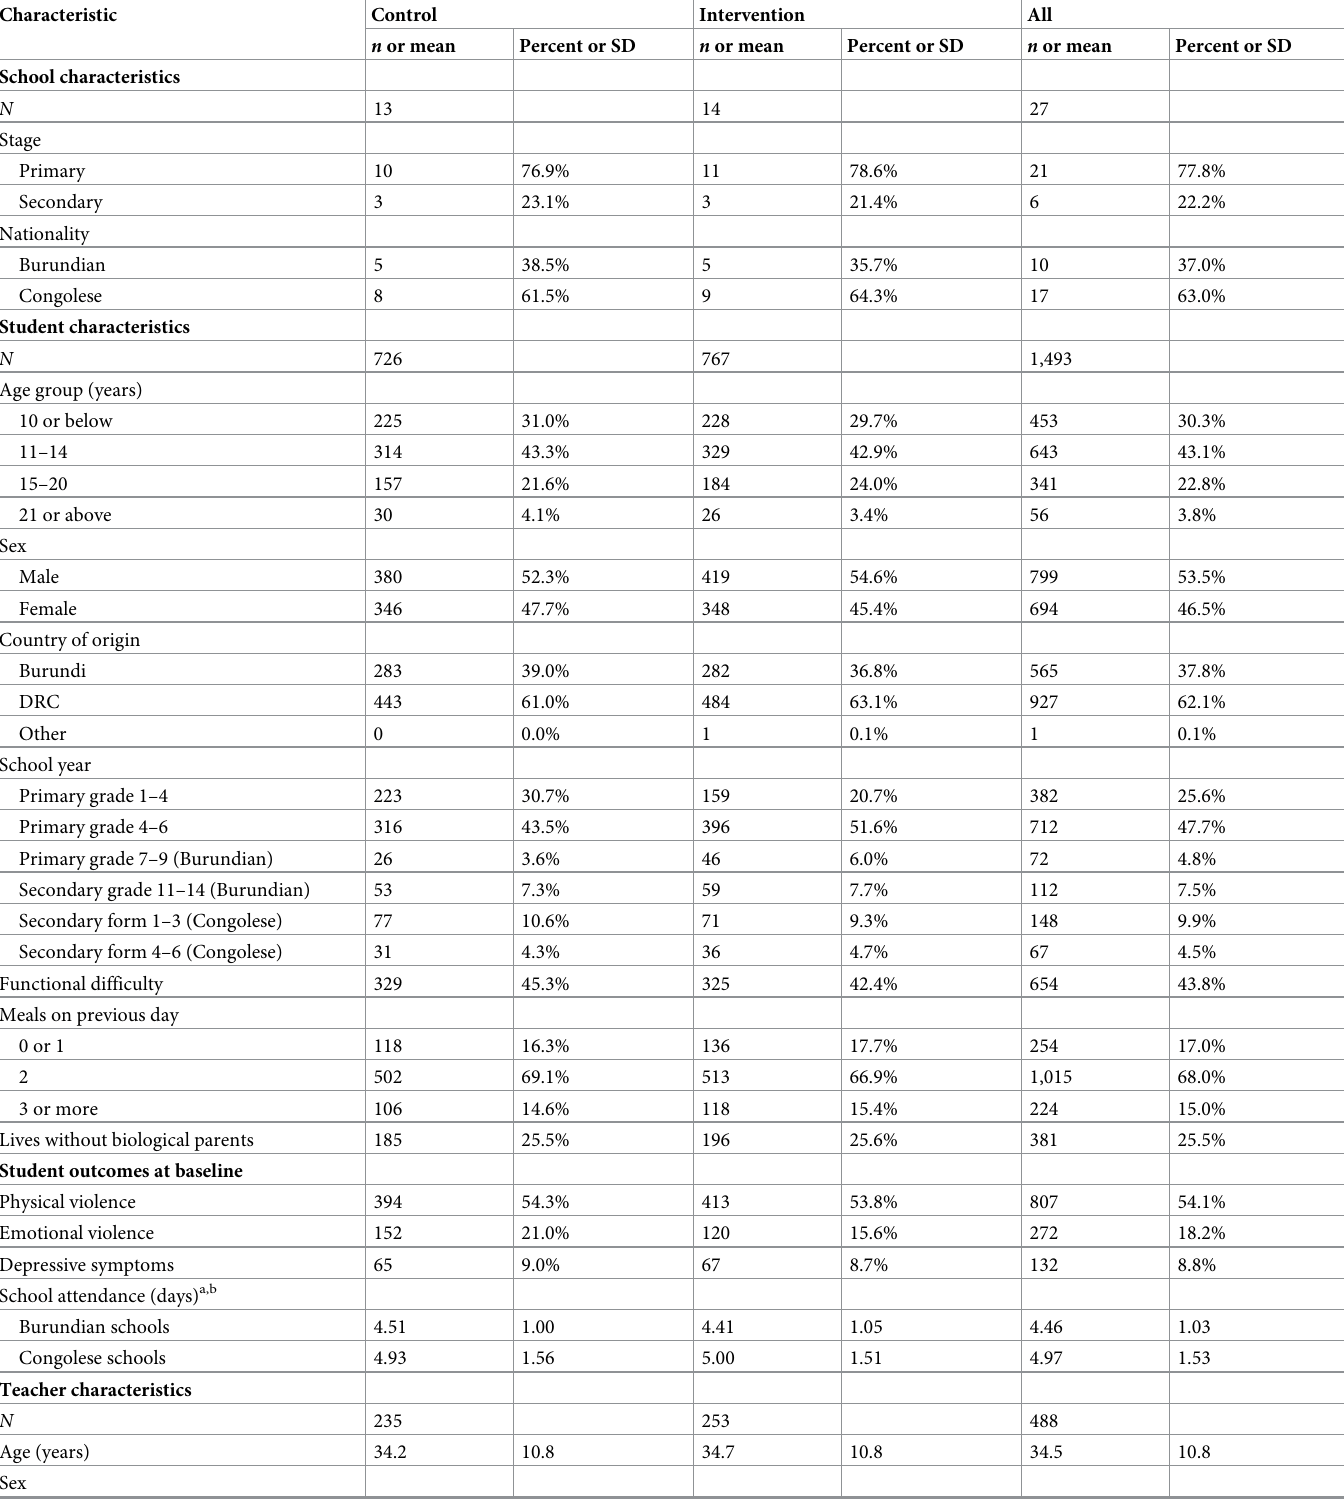
Table 1. Baseline